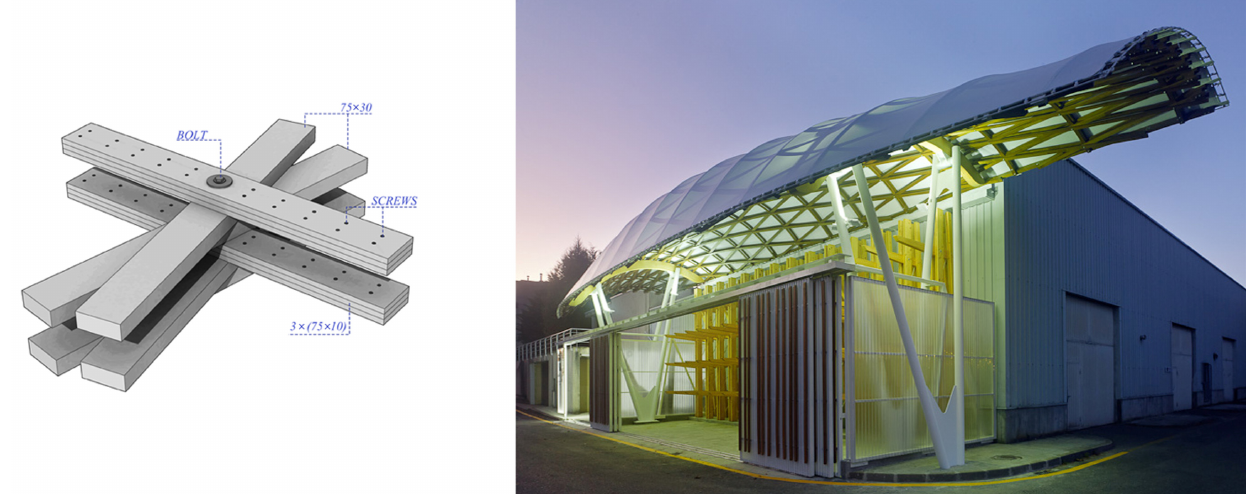
Figure 2. TEL-gridshell concept. Detail of the nodal joint ( left ) and general view of the first permanent TEL-gridshell ( right ).